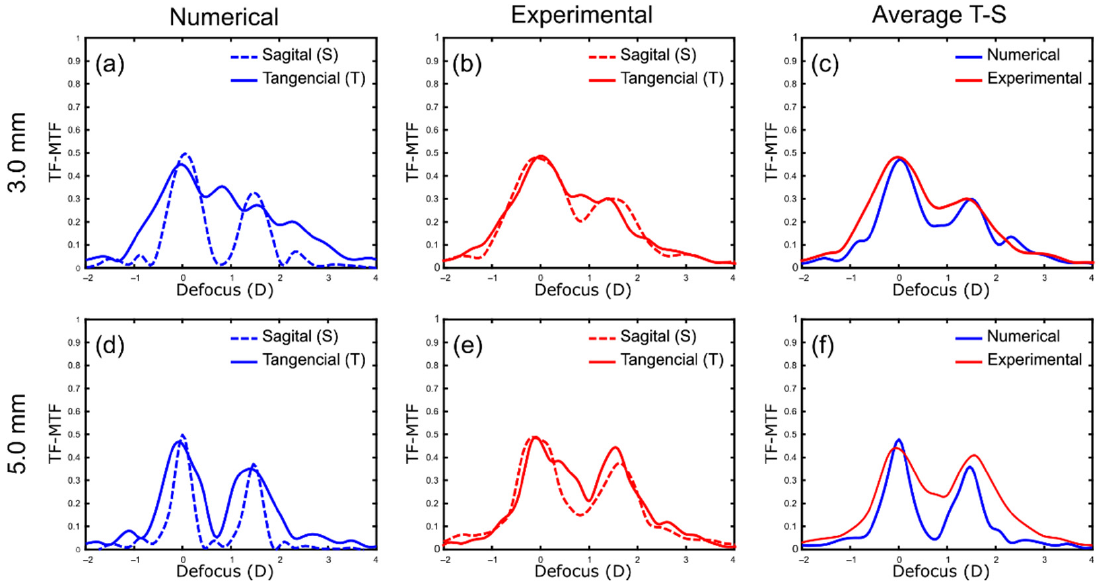
Figure 3. Numerically calculated ( a , d ) and experimentally obtained ( b , e ) monochromatic tangential and sagittal MTFs. The average MTFs, numerical (blue lines) and experimental (red lines), for 3.0 mm and 5.0 mm pupil diameters are shown in the graphs on the right ( c , f ).